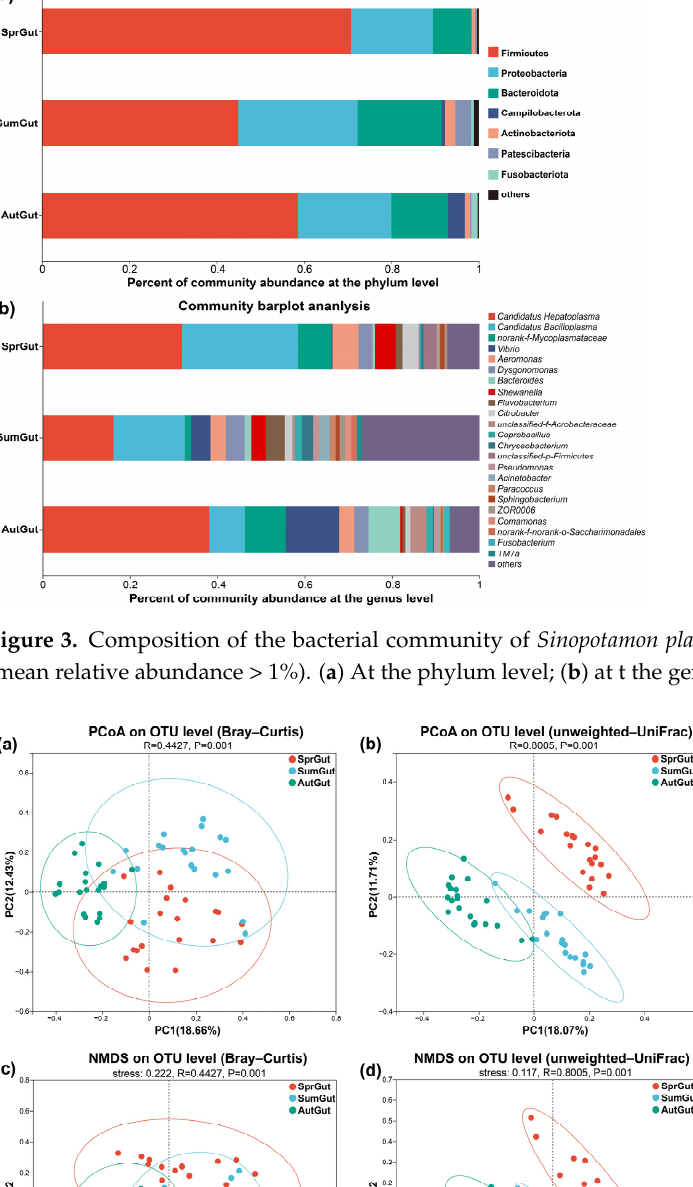
Figure 5. Venn diagram based on OTU level in the studied seasons ( a ) and classi fi cation of shared OTUs at the phylum level ( b ). To explore the microbial community composition variation between the three gut groups, we performed a LEfSe analysis with an all-against-all strategy to detect di ff er- ences in the relative abundance of the bacterial taxa (including phylum and genus) (Figure 6a,b, Table S4). At the phylum level, our LEfSe analysis results revealed that the Firmicutes were signi fi cantly enriched in the SprGut-group, the Nitrospirota, and Deinococcota sig- ni fi cantly enriched in the SumGut-group, and the Campilobacterota and Fusobacteriota